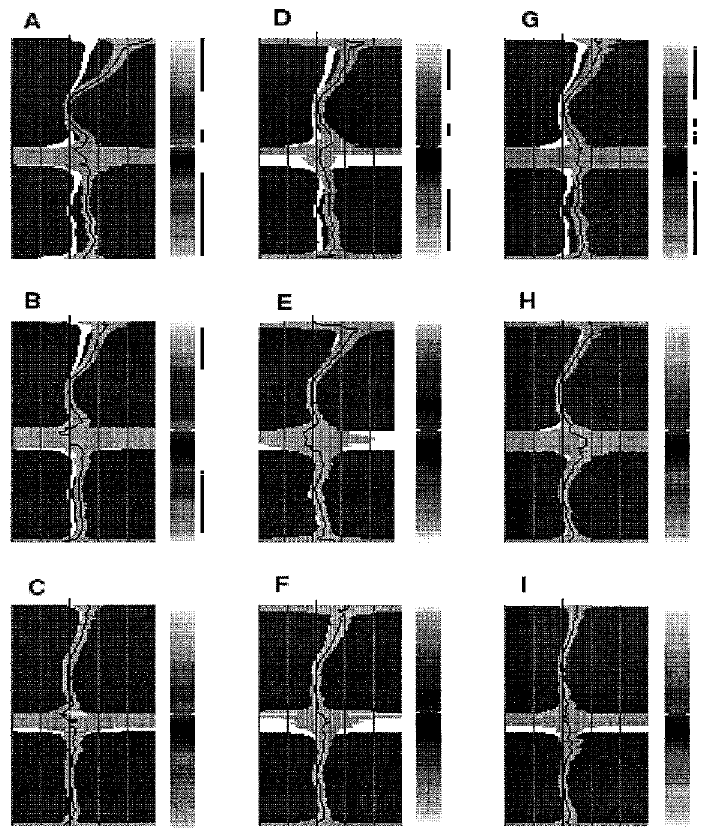
Fig. 3. Examples of fluorescence ratio profiles from CGH analysis, showing chromosome 1. The upper row shows the results of the CGH analysis of DNA from K-562 nuclei that were flow sorted from the 3 mixtures containing 32% (A), 13% (D), and 5% (G) K-562 cells, respectively. In all cases 3 amplifications are indicated, corresponding to those found when analysing pure, unsorted K-562 cells. The middle row shows the CGH profiles from the unsorted mixtures containing 32% (B), 13% (E), and 5% (H) K-562 cells. Two out of 3 amplifications are found in the 32% mixture, the other mixtures appear normal. The bottom row (C, F and I) shows the CGH profiles from analyses with the sorted normal lymphocytes, without aberrations. The black line indicates the mean ratio profile and the grey area indicates the 99.9% confidence interval of the experimental material. The white area (in some cases partly covered by the gray area) indicates the 99.9% confidence interval of the standard reference material scaled to give the best fit of each analysis. The fixed limits of 0.75, 1.0, 1.25, and 1.50 are indicated as well. The imbalances are indicated with bars either to the left (deletions) or to the right (amplifications) of the mean inverted DAPI chromosome. By scaling the standard reference interval the discrepancy between the confidence interval of the CGH profile of the case and the standard reference interval is automatically minimized (4). In our protocol, depending on the quality of the hybridization, 1p tends to drift toward a high green/red ratio. Even though the 1p profiles from the sorted K-562 cells of the 5% mixture (G) and from the unsorted 13% mixture (E) showed little or no differences in the actual ratio values, the comparison with the scaled reference interval reveals a significant